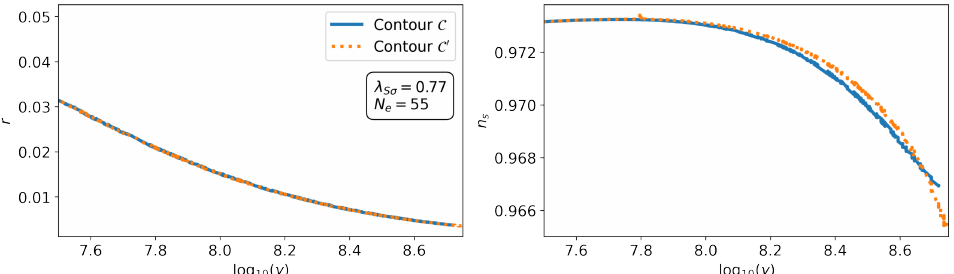
Figure 11 . Inflation parameters computed along the two contours C and C 0 : tensor-to-scalar ratio r (left) and scalar spectral index n s (right). Note that the relation between γ and β S is different for contours C and C 0 , which can be understood from figure